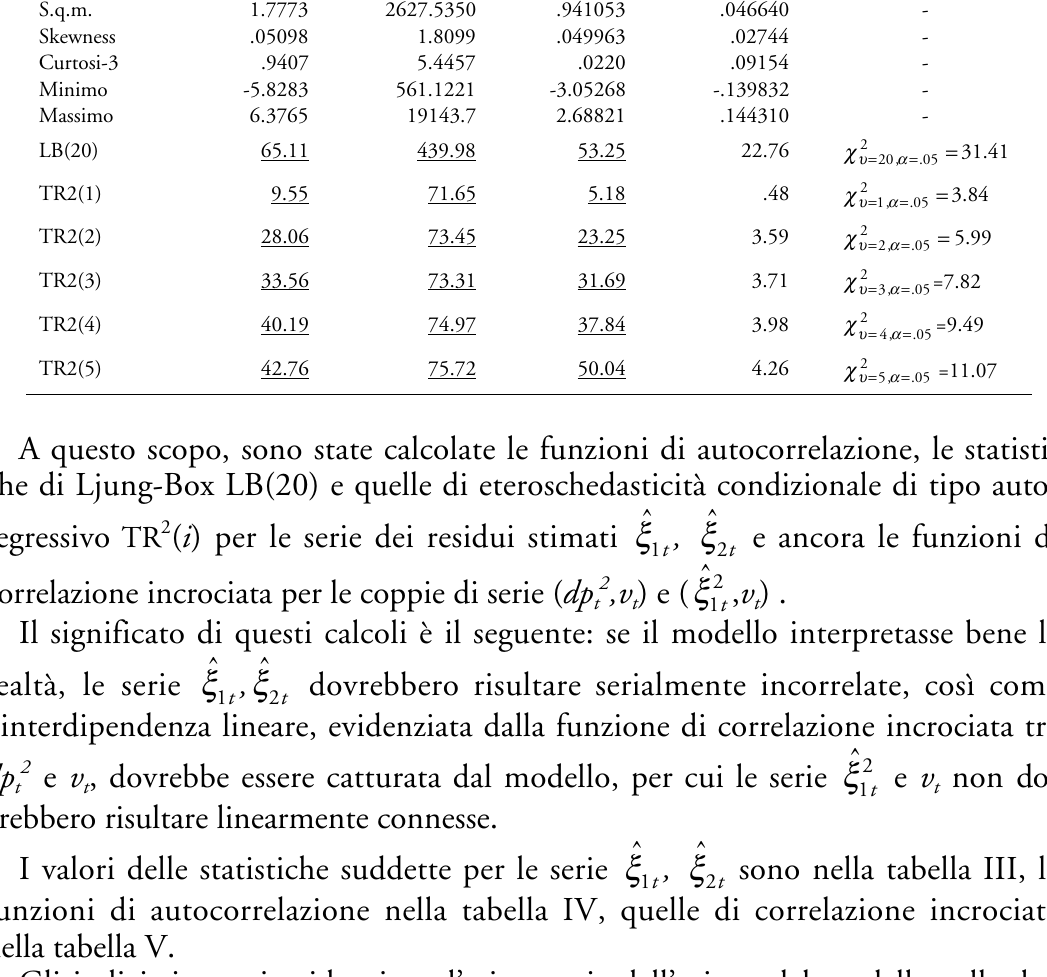
, v , ˆ ξ e ˆ ξ . t t 1 t 2 t